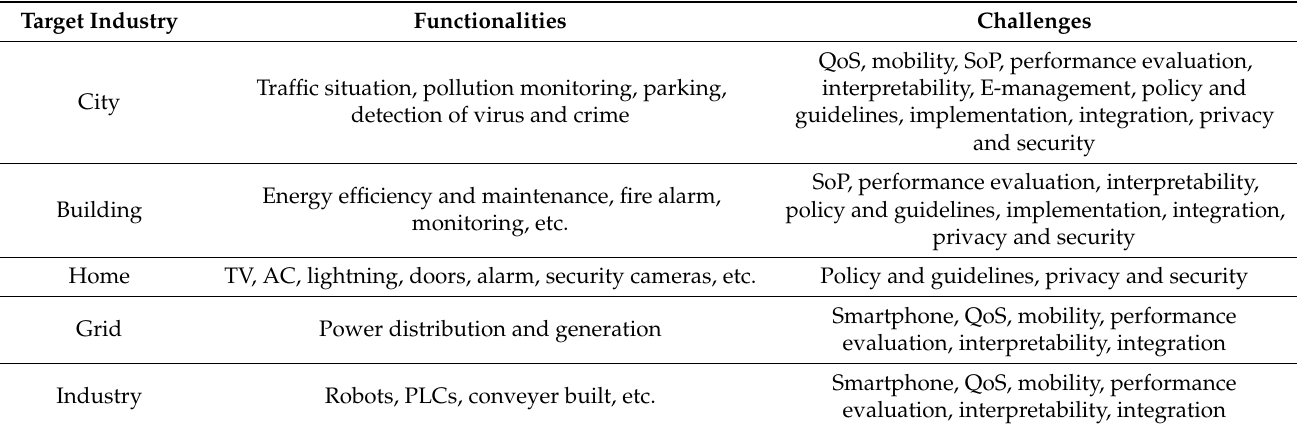
Table 1. Challenges of the Target